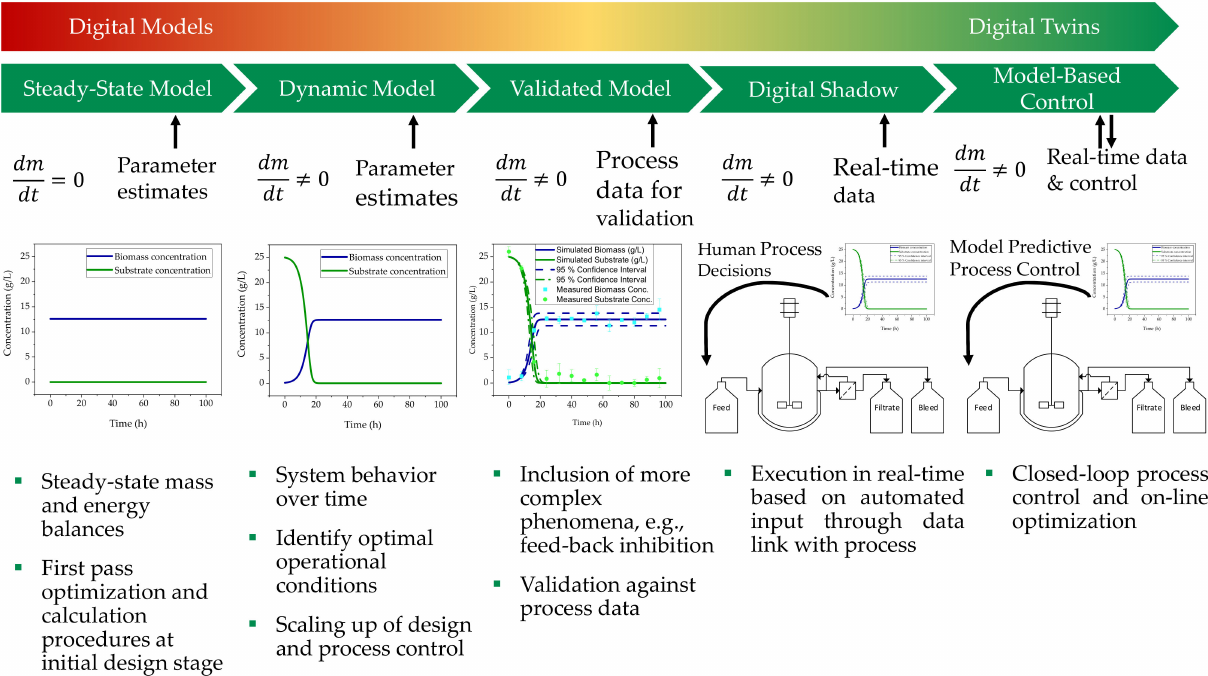
Figure 1. Levels of a digital twin, starting from a steady-state model to a dynamic model, a validated model, and a digital shadow to a model-based